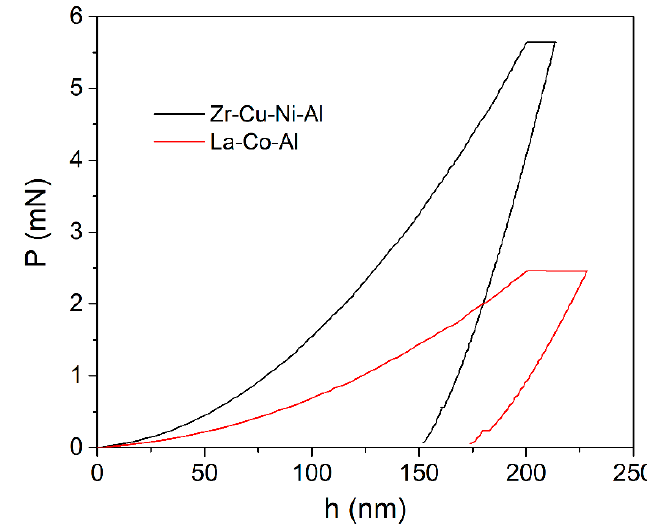
Figure 2. Representative load-displacement curves of the 500-s holding creep tests with a maximum displacement of 200 nm for Zr-Cu-Ni-Al and La-Co-Al films.